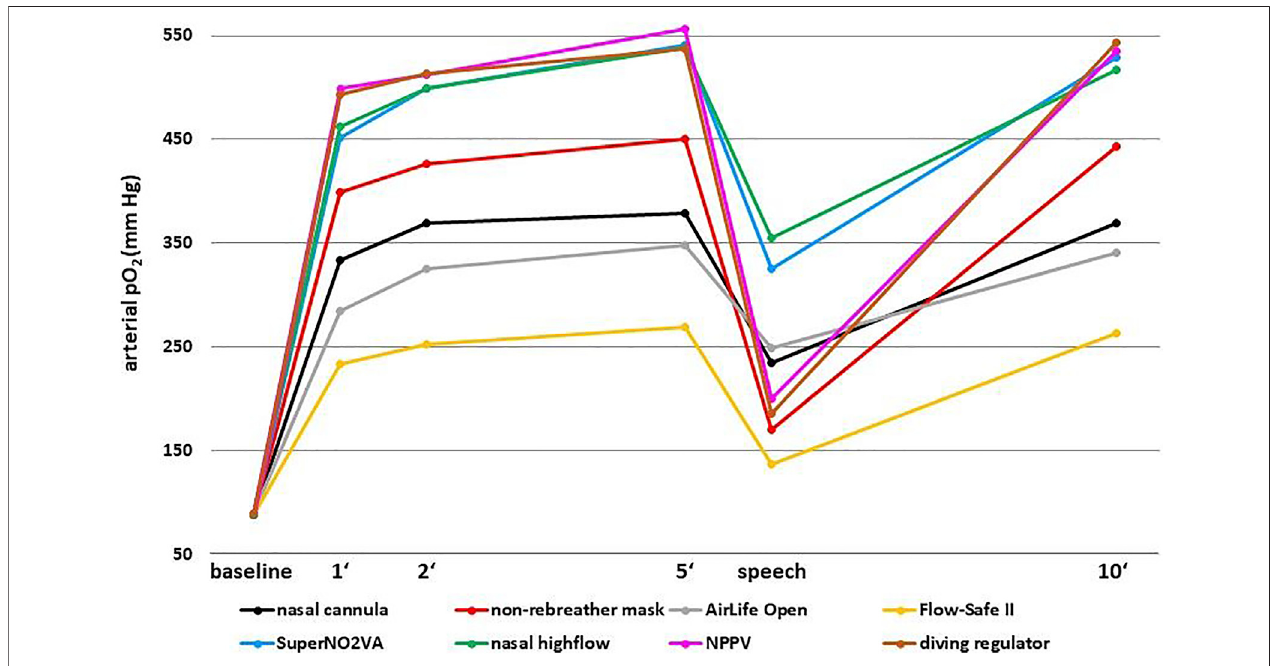
FIGURE 2 | Mean arterial pO2 (mm Hg) achieved with the different oxygen